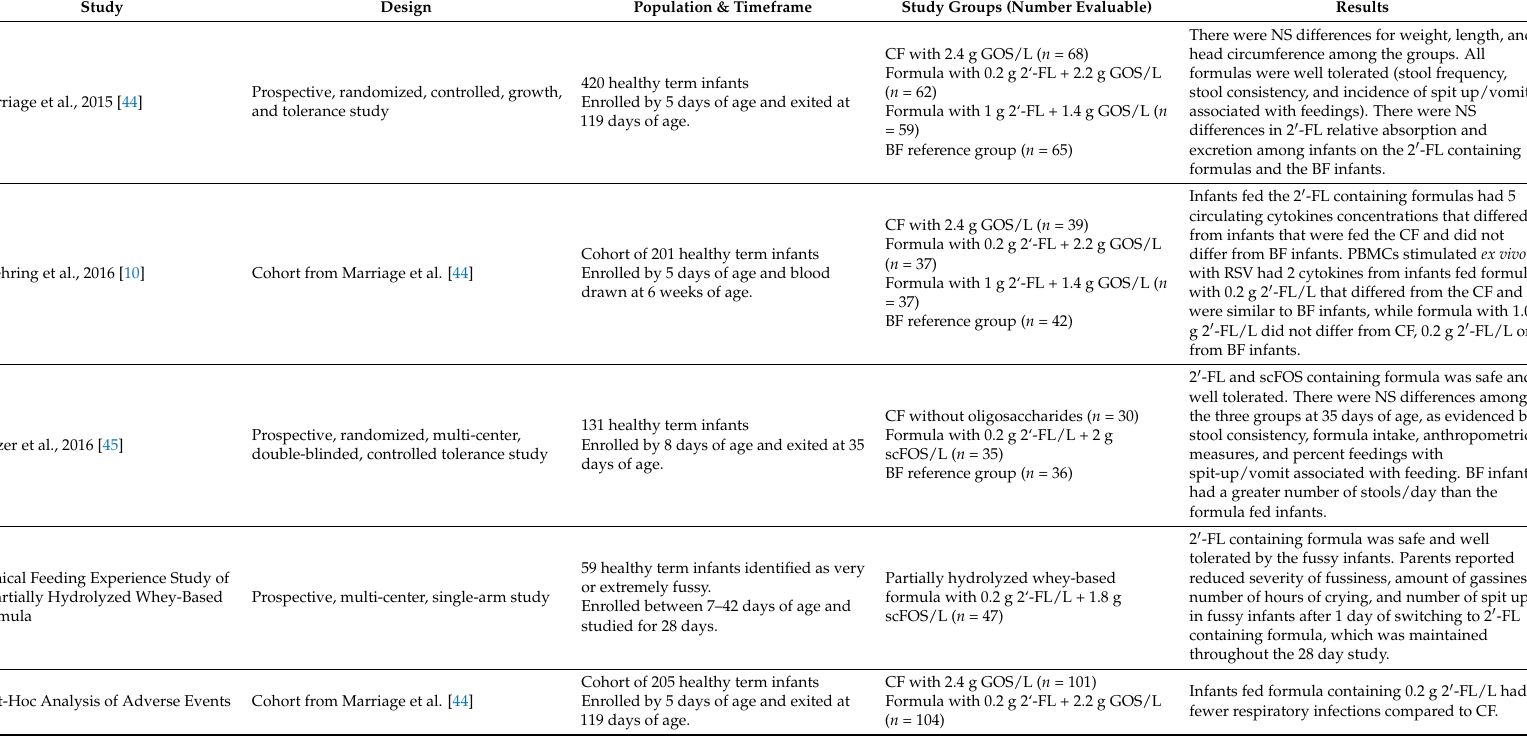
Table 1. Summary of Clinical Experiences of Infants Fed 2 (cid:48) -FL Containing